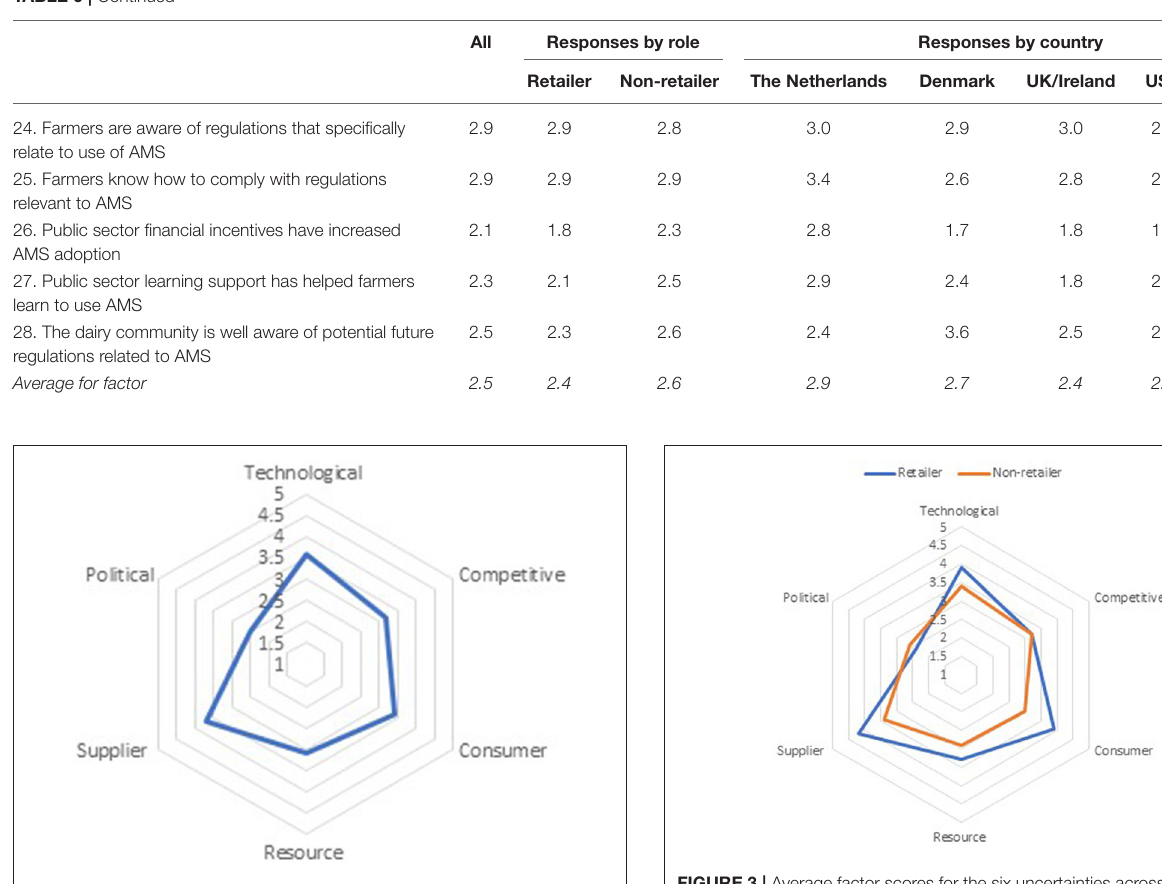
FIGURE 2 | Average factor scores for the six uncertainties across all responses (scale of 1–5 where 1 = strongly disagree, 5 = strongly agree).